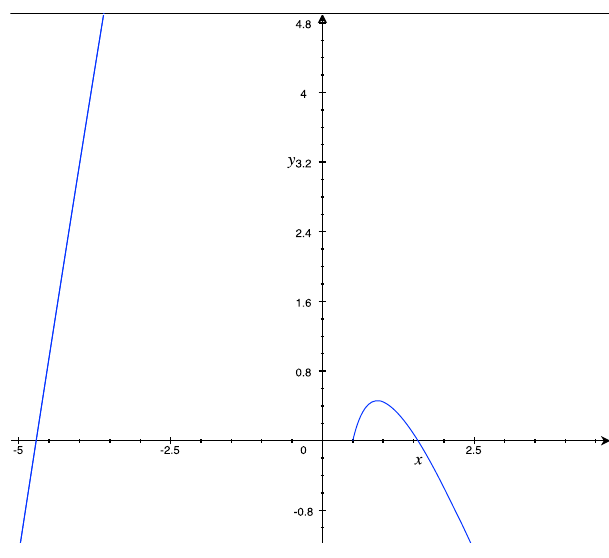
Figure 4: Close up of the graph (cid:5) for μ 0 > su ffi ciently